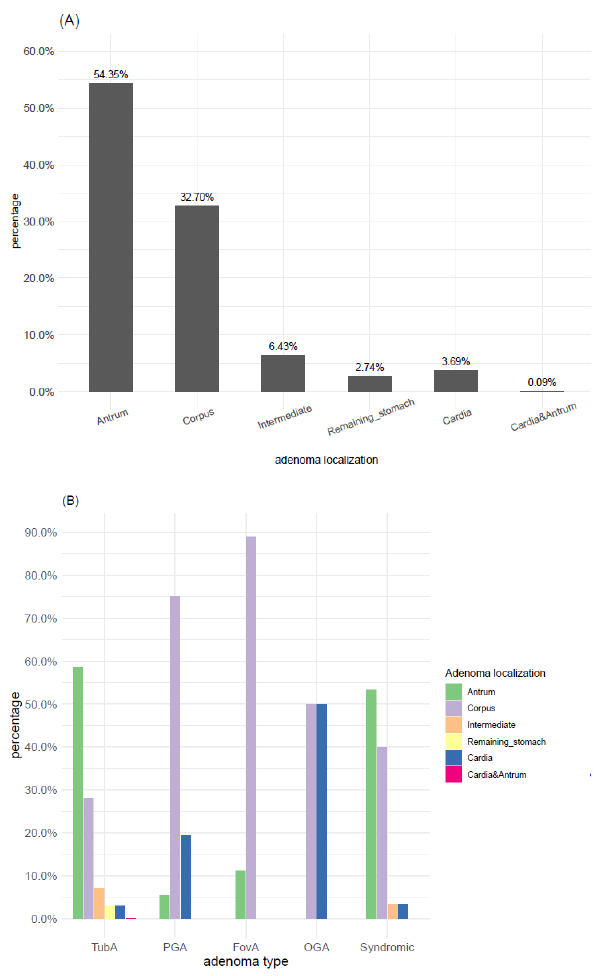
were associated with A-gastritis. No predominant gastritis type was detected for the four OGA samples. Figure 4. Adenoma type and localization. ( A ) Frequency distribution of adenoma localization. ( B ) Distribution of adenoma localization within adenoma types. TubA: intestinal-type adenoma; PGA: pyloric gland adenoma; FovA: foveolar-type adenoma; OGA: oxyntic gland adenoma.